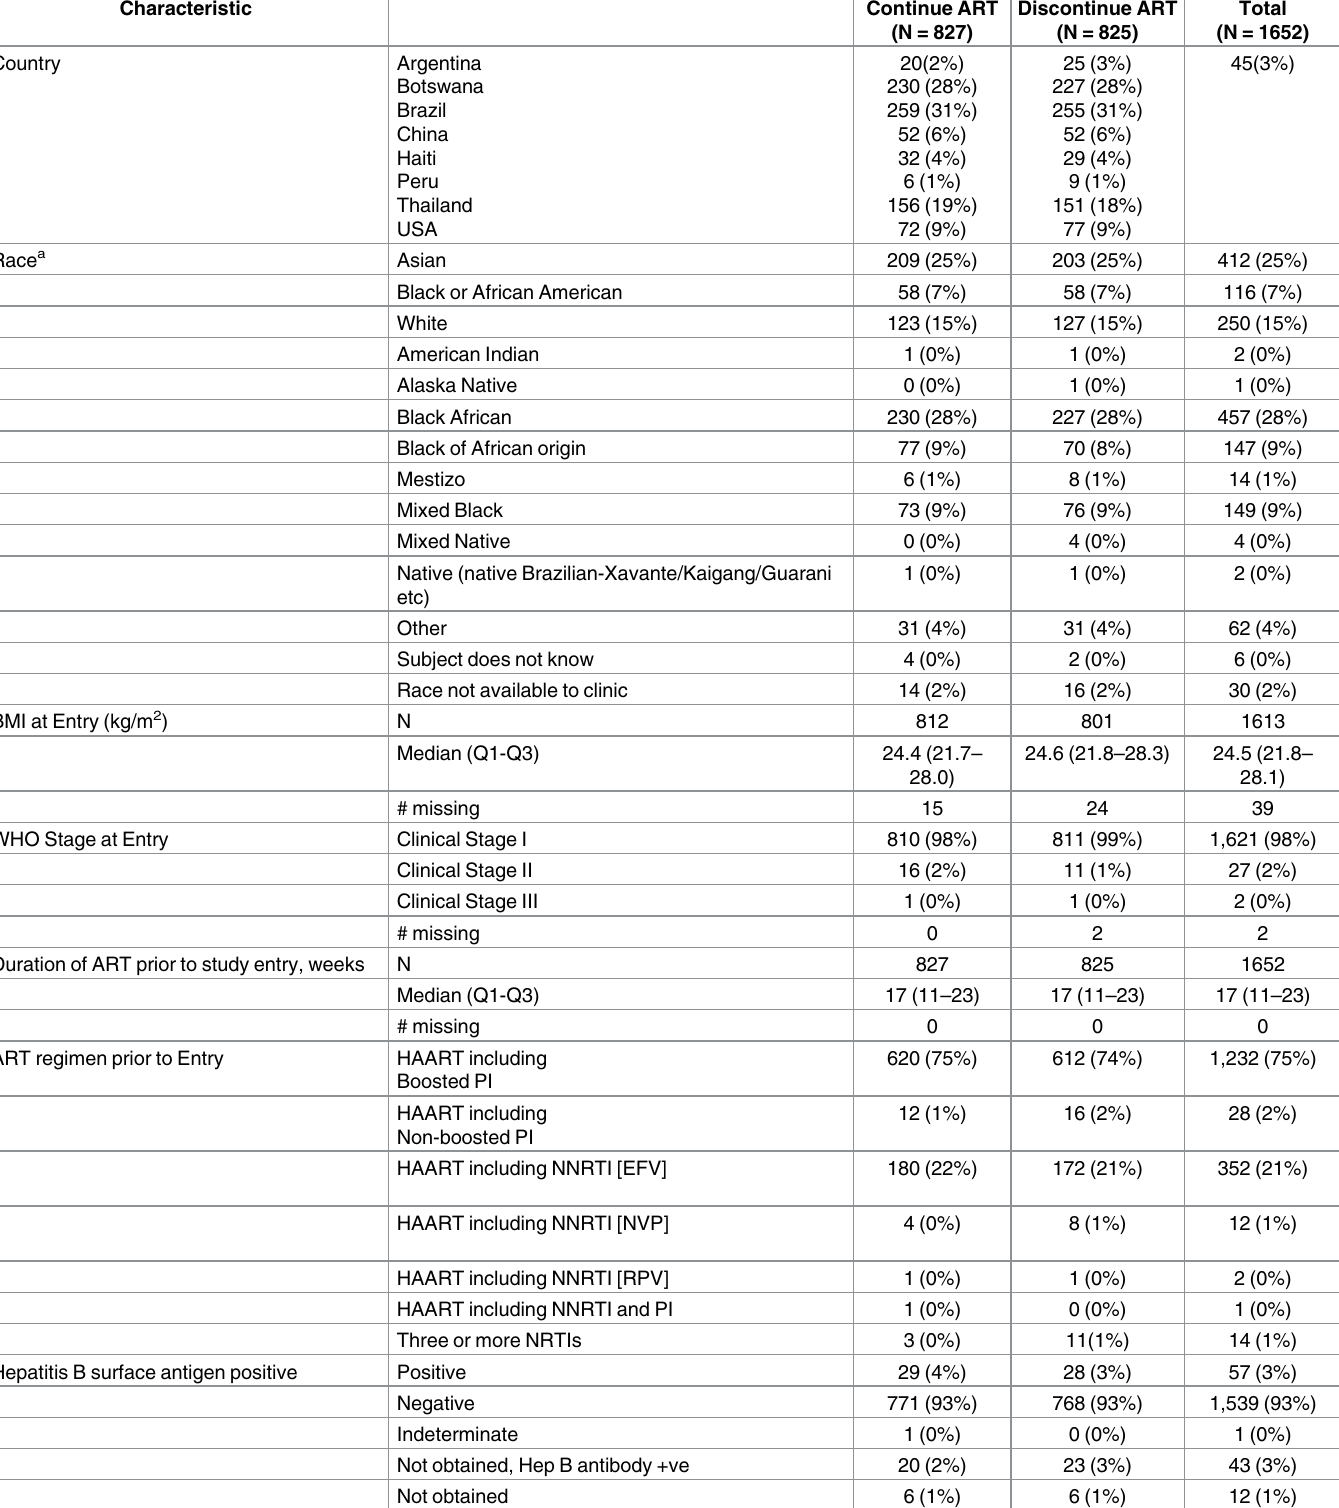
Table 1. Baseline